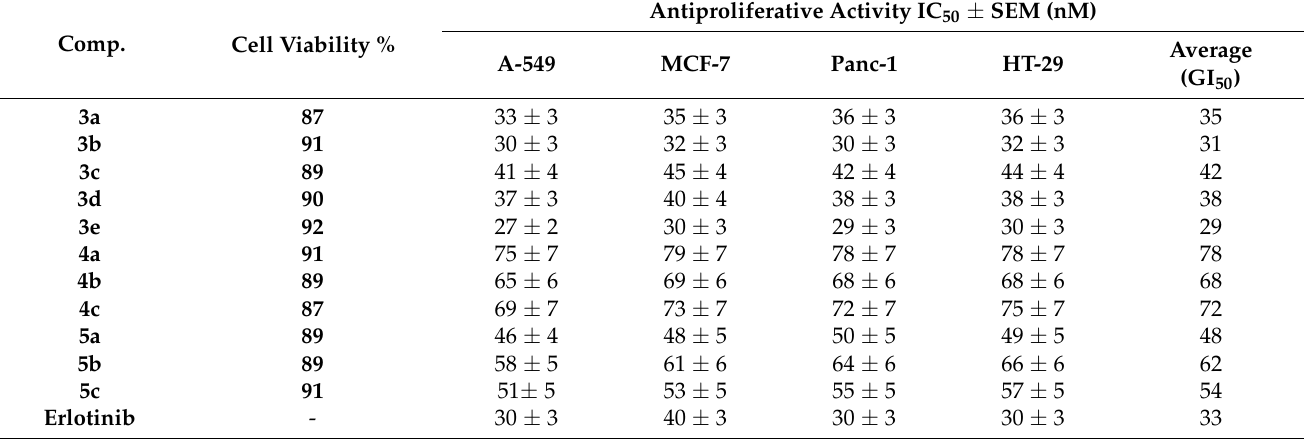
Table 1. IC 50 of compounds 3a–e , 4a–c , 5a–c , and erlotinib.